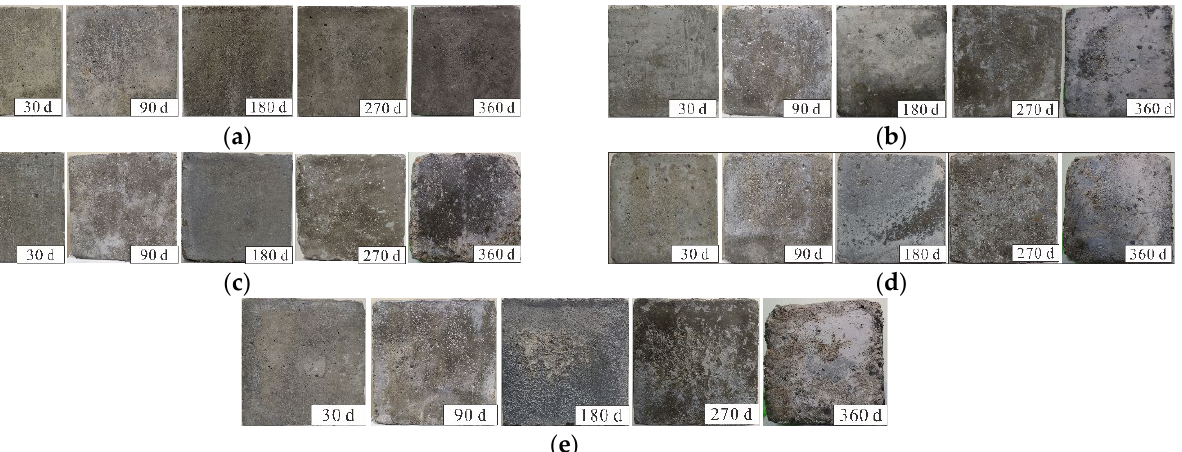
Figure 1. Changes in sample appearance after immersed in: ( a ) C; ( b ) CS0.2-M; ( c ) CS0.5-M; ( d ) CS0.7-M; ( e ) CS1-M.